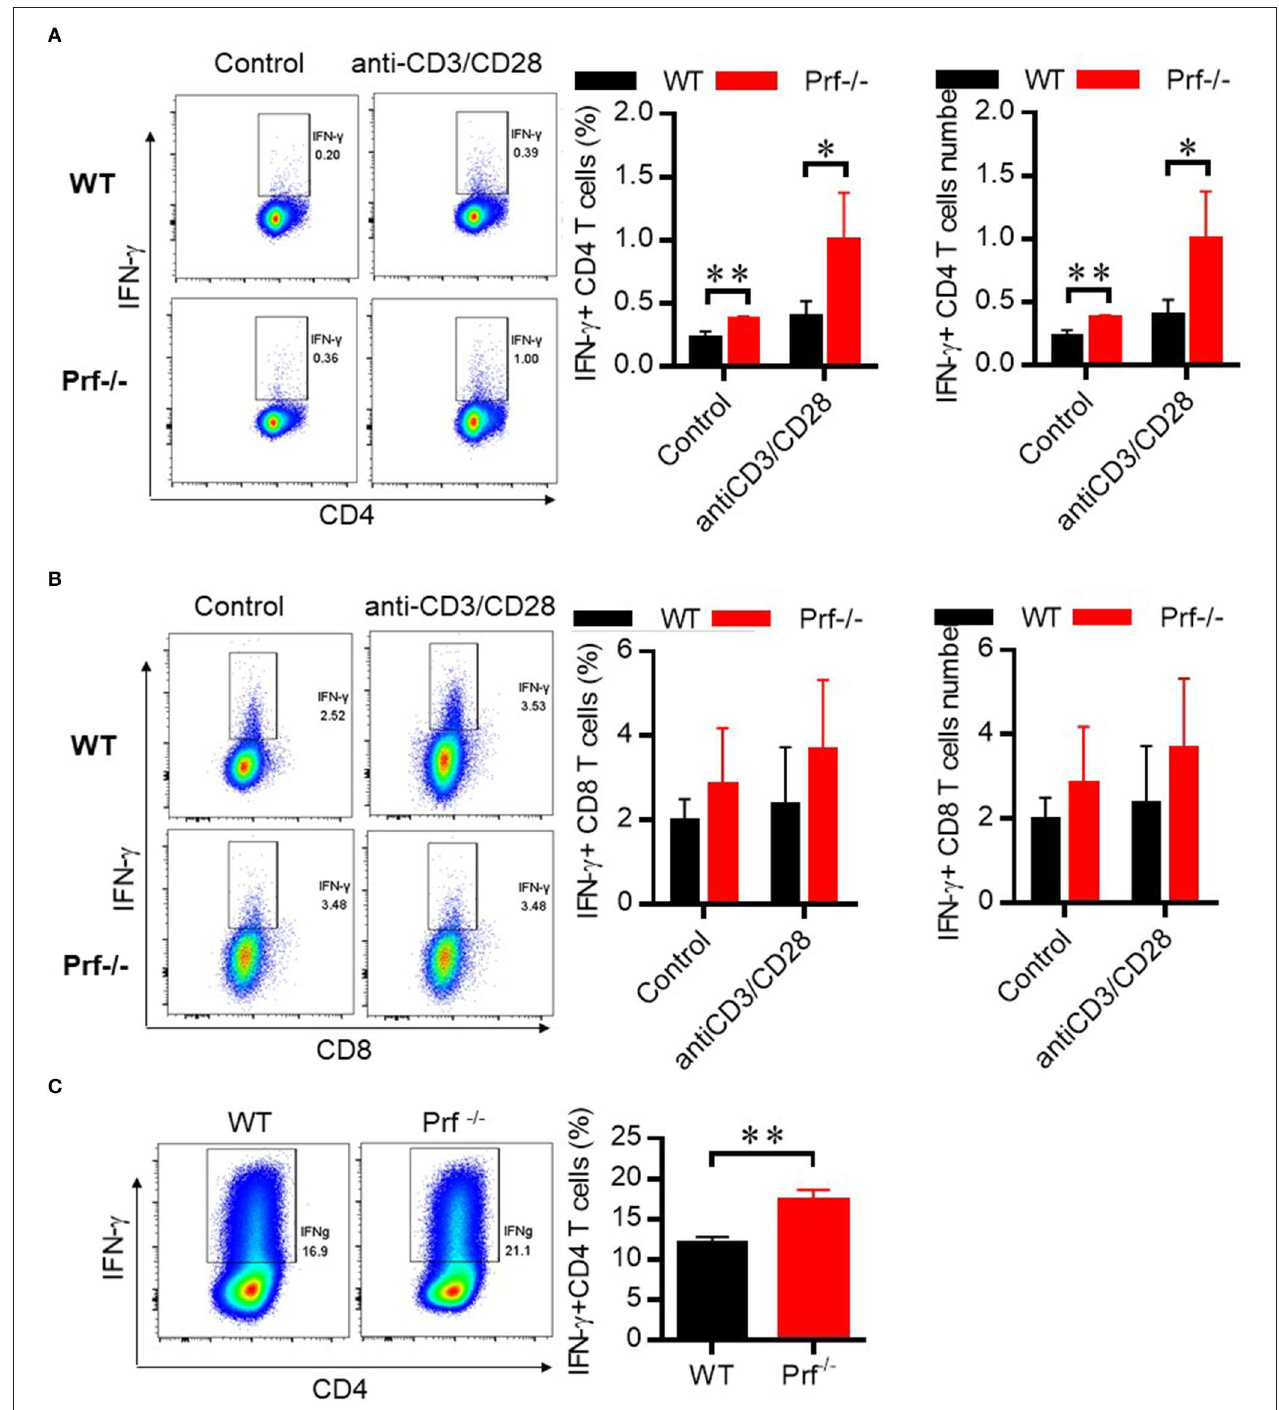
FIGURE 7 | CD4T cells in Prf − / − mice have an intrinsically elevated ability of IFN- γ production. CD4T cells (A) and CD8T cells (B) from WT and Prf − / − mouse spleens were cultured in media supplemented with GolgiStop in the presence or absence of plate-bound anti-CD3 plus anti-CD28 for 4–6h and then stained for intracellular IFN- γ (left, percentage; right, cell number, n = 5–6). (C) Naive CD4 + T cells were sorted from the spleen of WT or KO mice and differentiated to Th1 cells for 3 days. The IFN- γ production in these cells was detected by flow cytometry. Representative FACS plots and total cell number of IFN- γ + CD4 + T cells were shown. The data shown in each panel of the figures were collected from a single experiment, and each experiment was repeated for at least three times and rendered consistent results. Means ± SEM, * p < 0.05; ** p < 0.01.